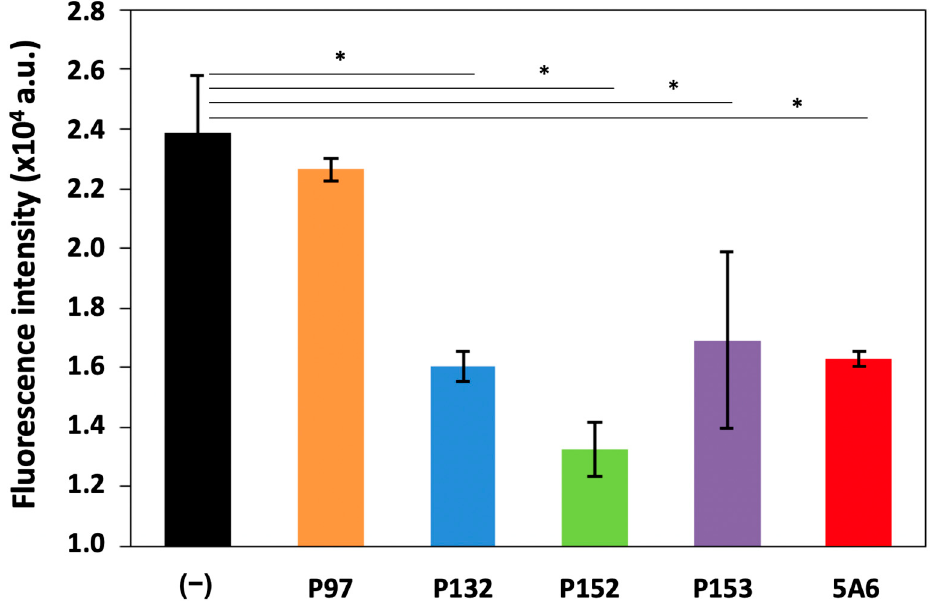
Figure 4. Fluorescence intensity derived from MDA-MB-231 human breast cancer cells that migrated to the opposite side of the membrane in the Boyden chamber assay. MDA-MB-231 cells were treated with a candidate peptide (P97, P132, P152, or P153) or an anti-human CD81 antibody (5A6), at a concentration of 100 nM. ( − ), no treatment. Error bars show SD (n = 3). *, p -value < 0.05, t -test.